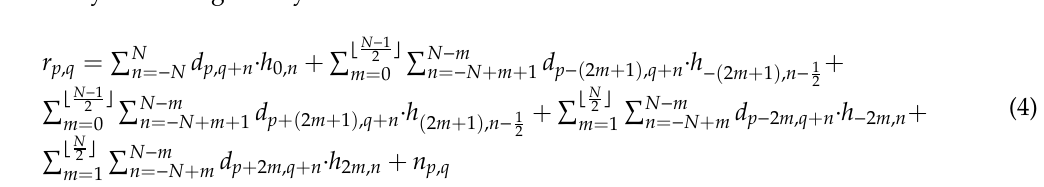
Figure 1. Bit-patterned media (BPM) structures of regular and staggered array.